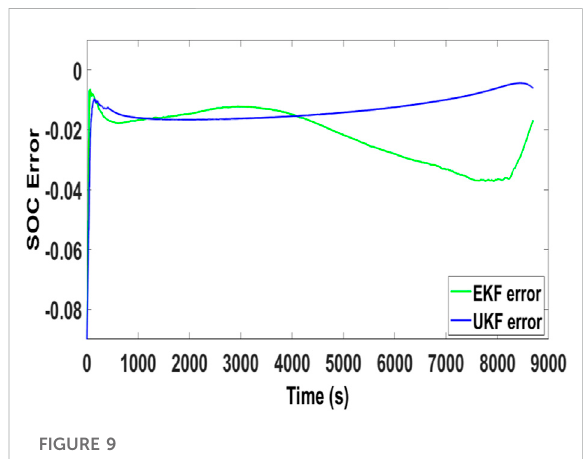
FIGURE 9 Comparison of SOC estimate error UDDS